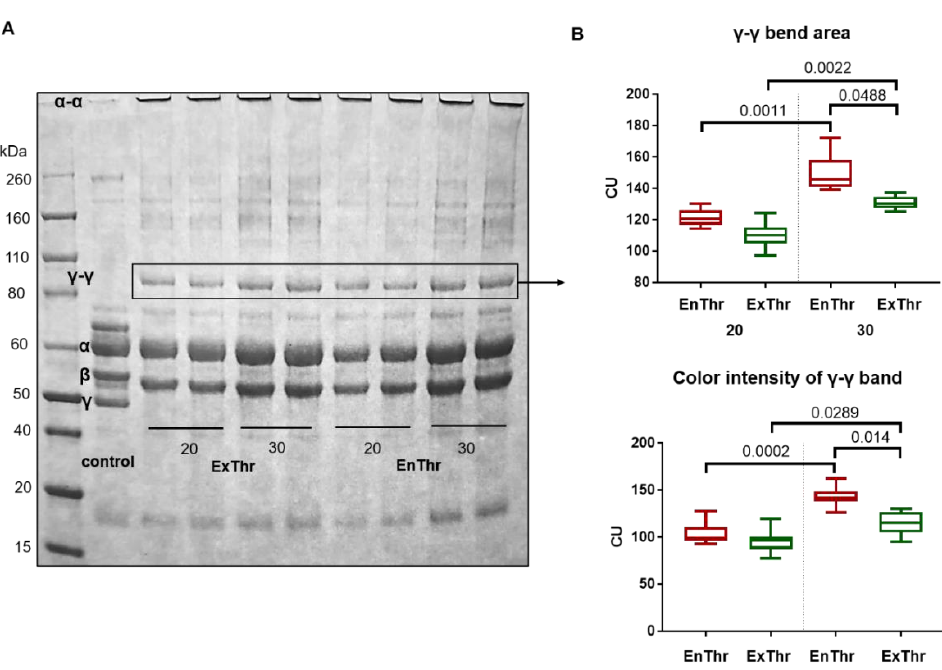
Figure 3. Cross-linking of fibrin matrices prepared at fibrinogen concentrations of 20 and 30 mg/mL using endogenous (EnThr) and exogenous (ExThr) thrombin: ( A ) SDS-PAGE analysis of fibrin matrices as compared to the unpolymerized fibrin solution (control); ( B ) quantitative analysis of γ - γ dimer bands, center lines indicate the median, box boundaries indicate the 25th and 75th percentiles and whiskers indicate range.